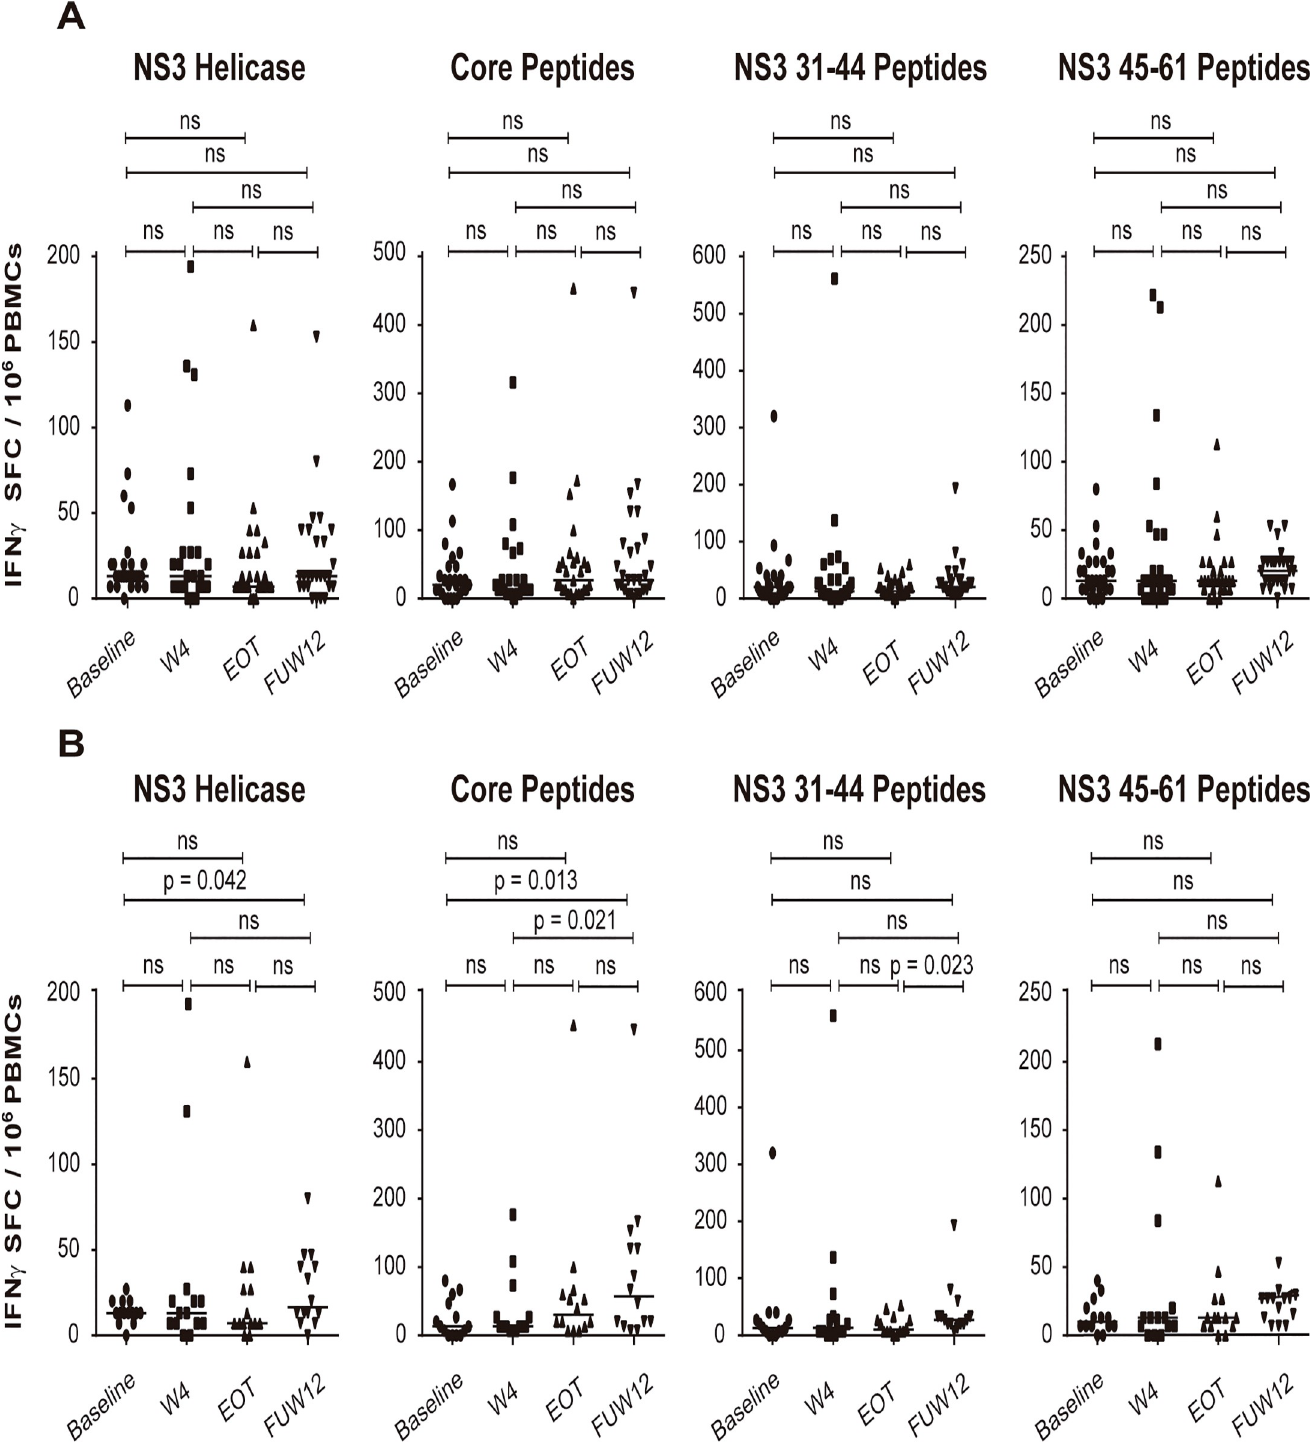
Fig 2. HCV specific T cells immune response analyzed by IFN- γ ELISPOT. Results were expressed as number of SFC producing IFN- γ . (A) IFN- γ production of 10 6 PBMCs tested at baseline, W4, EOT, and FUW12. Total PBMCs where stimulated with HCV Peptides (NS3 Helicase, Core Peptides, NS3 31–44 Peptides and NS3 45–61 Peptides), (N = 27). (B) IFN- γ production of 10 6 PBMCs tested in subtype 1b patients (N = 14). Horizontal bars represent median of IFN- γ SFC and each dot represents IFN- γ response from one patient. Median of IFN- γ SFC between different times were compared with Wilcoxon signed-rank test. P < 0.05 was considered statistically